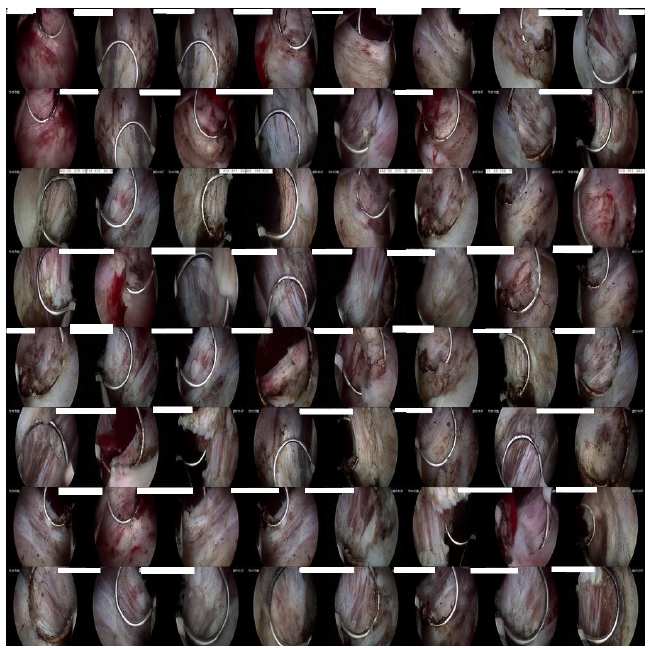
Figure 3. The prostate capsule has the characteristics of large-scale changes and different shapes.